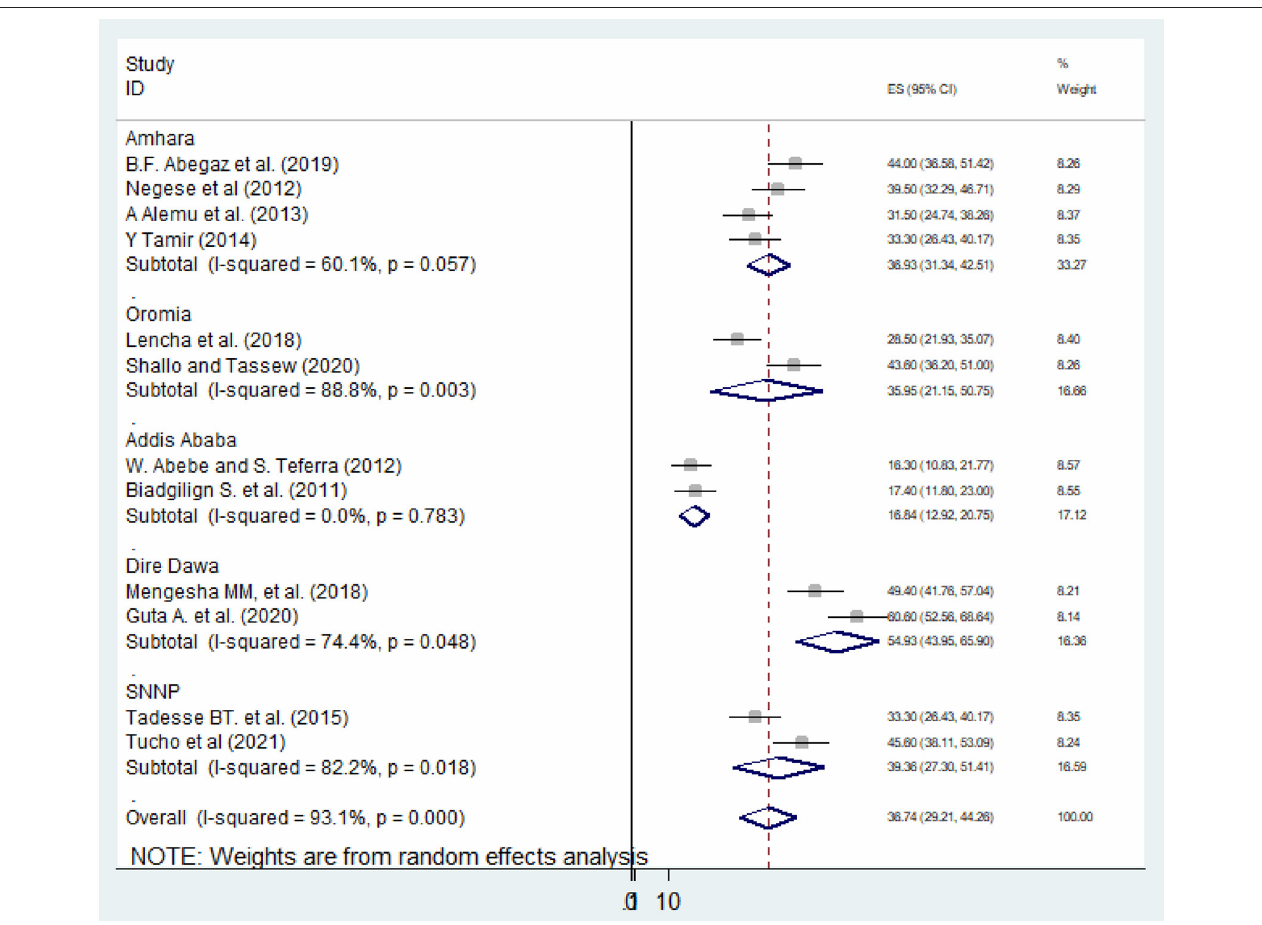
FIGURE 3 | Subgroup analysis of the prevalence of HIV serostatus disclosure among children in Ethiopia.